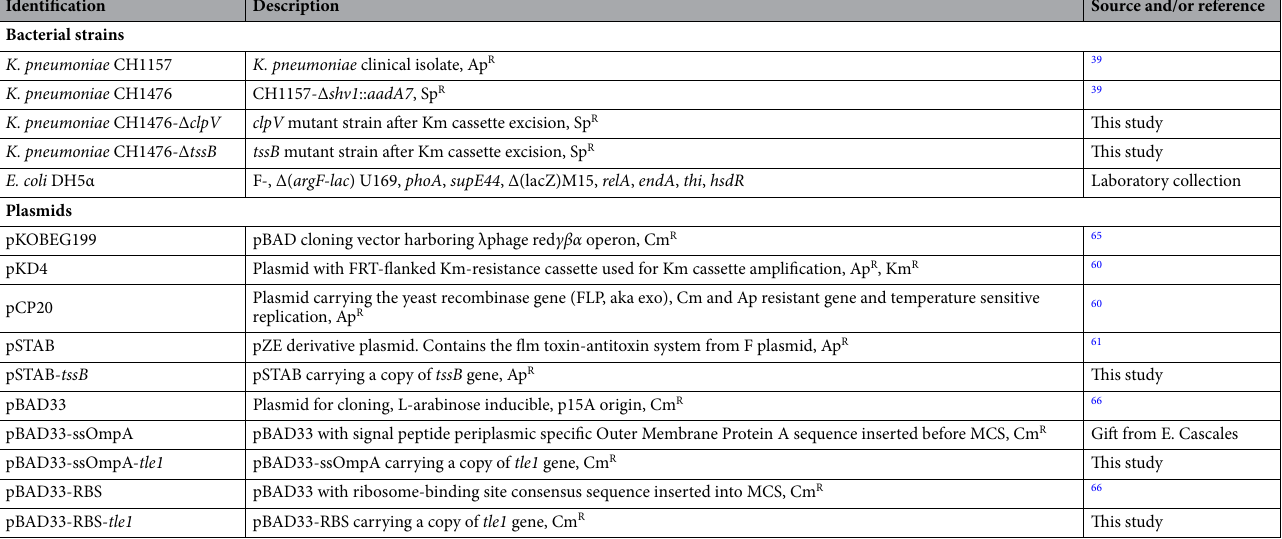
Table 1. Bacterial strains and plasmids used in this study. Abbreviations Ampicillin (Ap); Spectinomycin (Sp); Kanamycin (Km); Tetracycline (Tet); Chloramphenicol